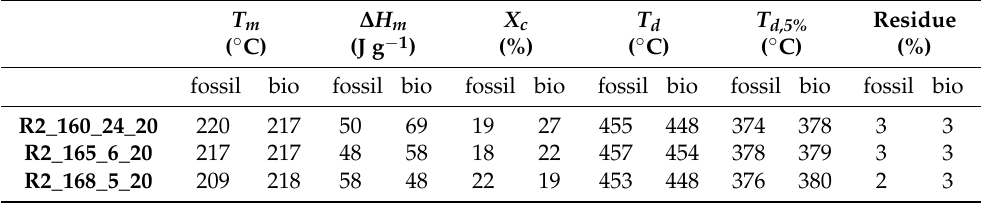
Table 8. Evaluation of time–temperature profiles tested: thermal properties of R2